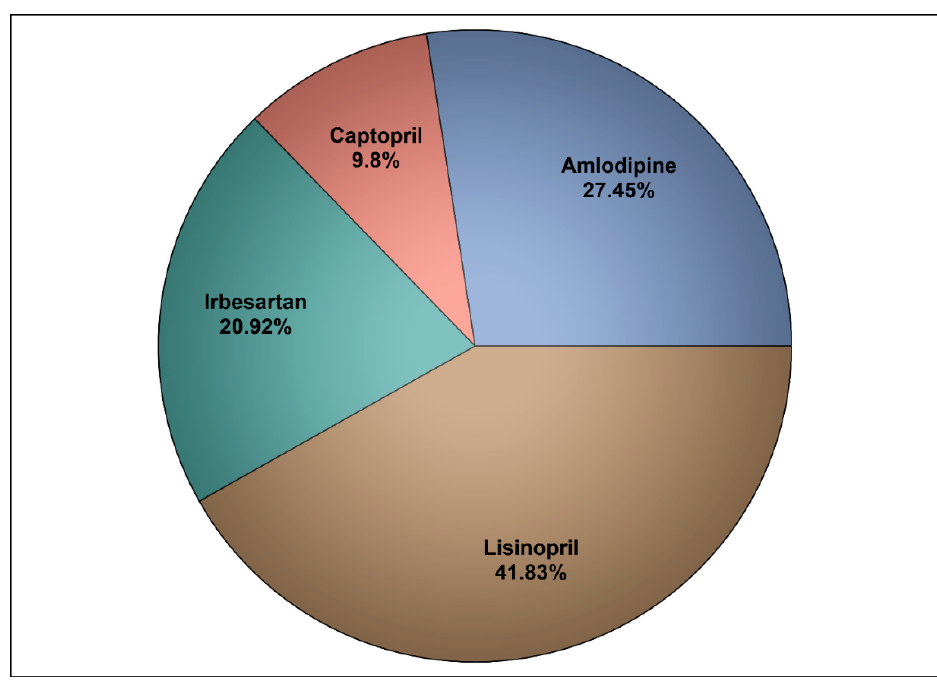
Figure 1. The utilization rates of ACEIs/ARBs and amlodipine among the study sample. Table 1. Patients’ baseline characteristics.